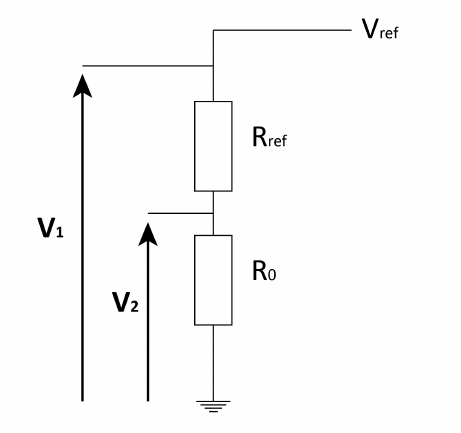
Figure 1: Schematic representation of the current- voltage